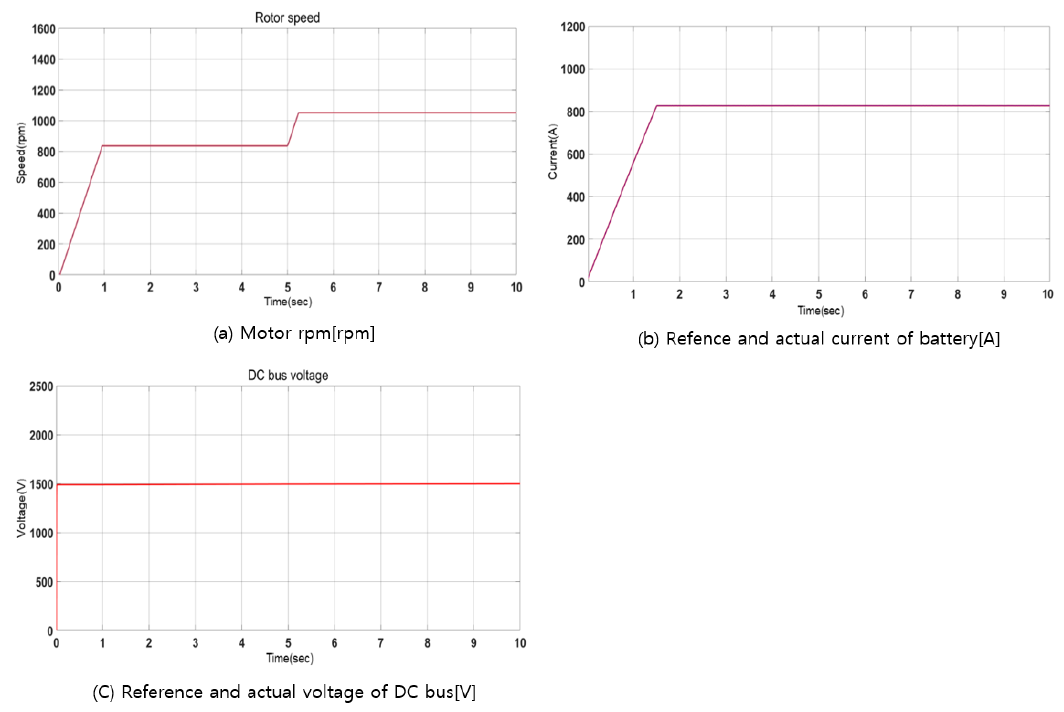
Figure 18. Simulation results of system when load varies as 10 → 20%.